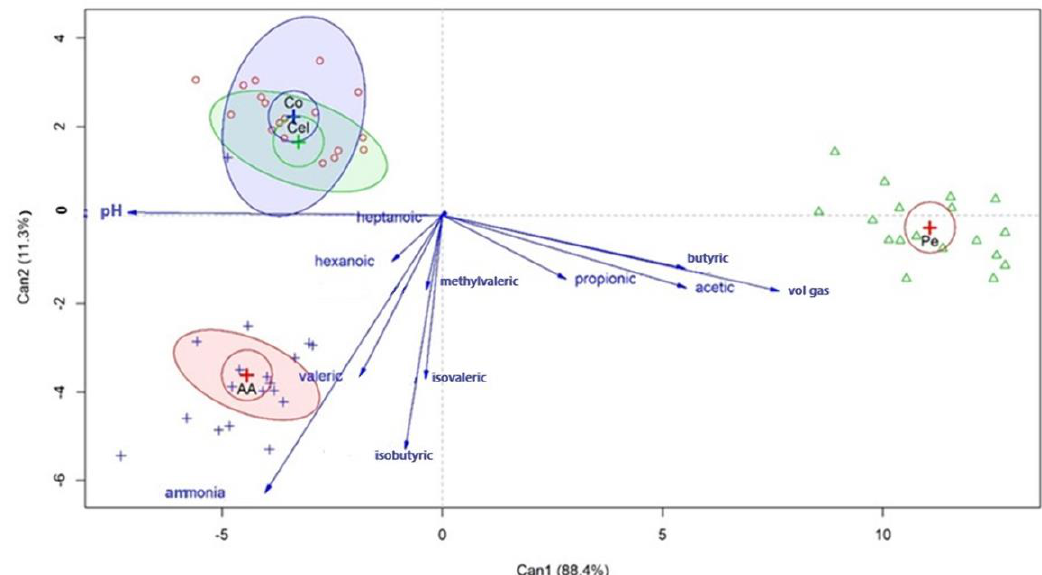
Figure 9. Biplot of principal component analysis using first and second principal components (PC1, 88.4%; PC2, 11.3%). Treatments are located according to their coordinates in the components. Vectors are related to the trend of variables in treatments.